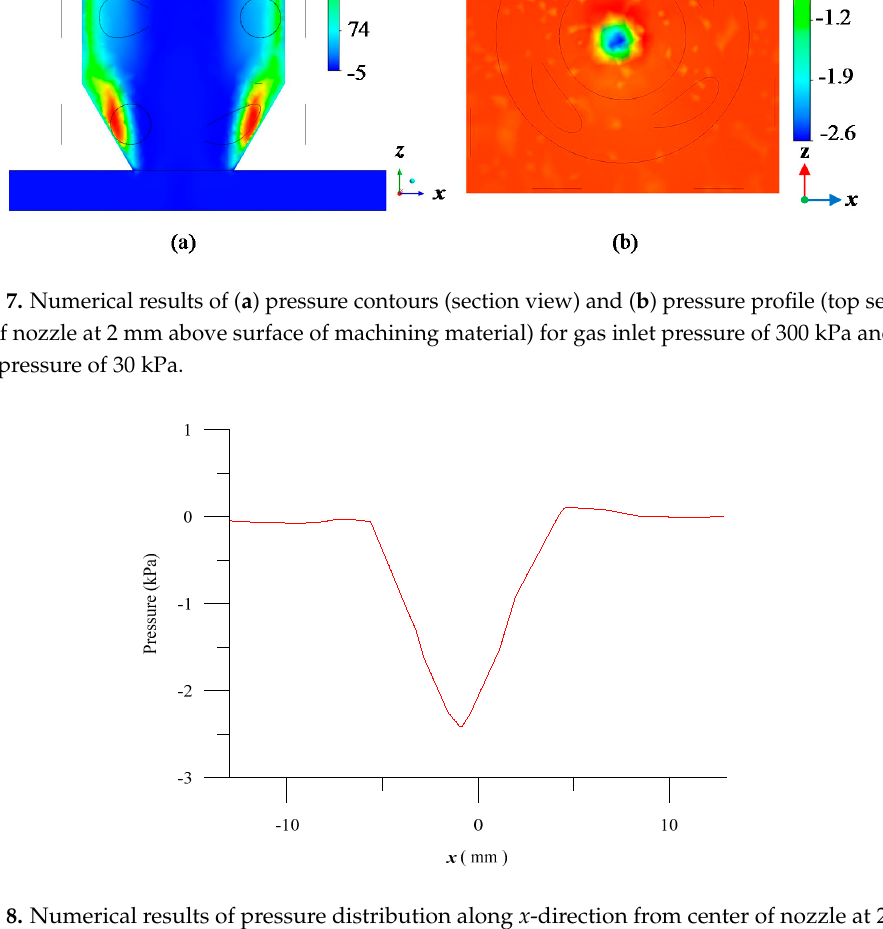
Figure 3. Numerical results of pressure distribution along x -direction from center of nozzle at 2 mm above surface of machining material for gas inlet pressure of 300 kPa and gas outlet pressure of 30 kPa.